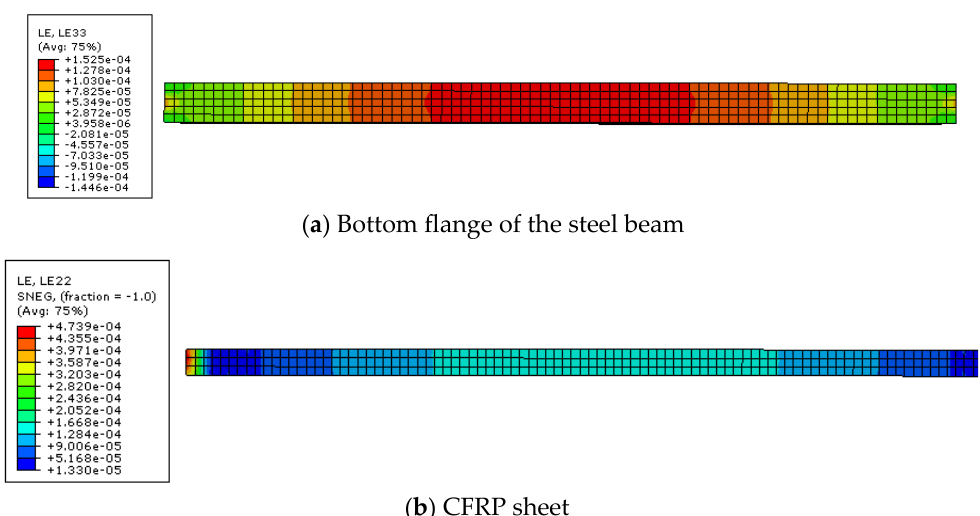
Figure 5. Strain distribution ata temperature of 20 °C.